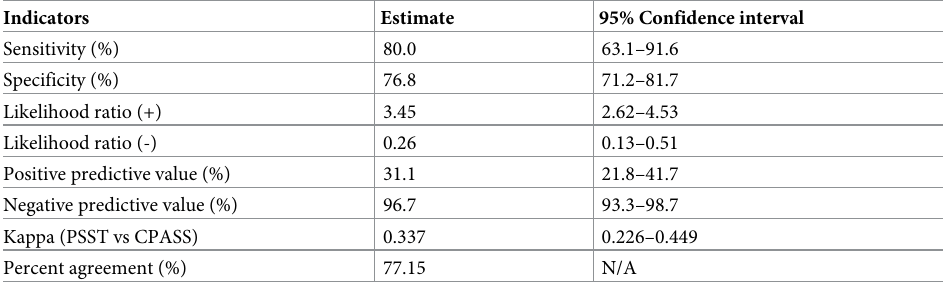
Table 2. Sensitivity and specificity of PSST (for PMS & PMDD) compared with